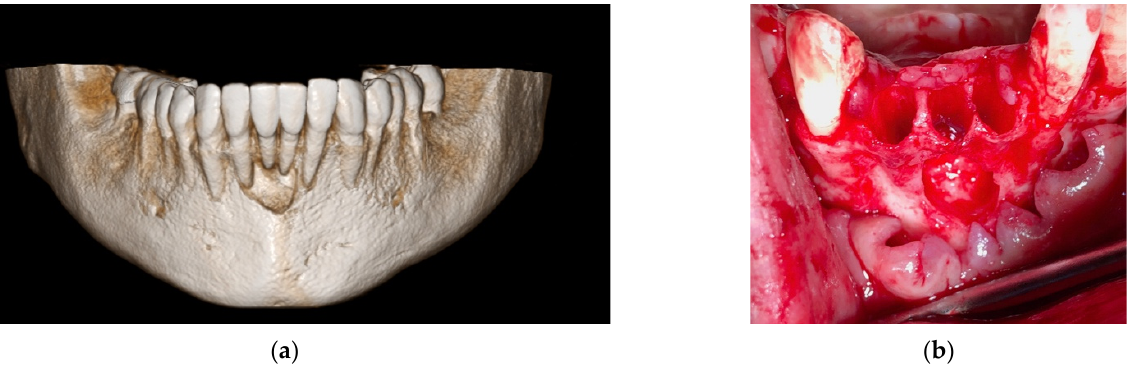
Figure 13. ( a ) Cystic lesion between lower incisors; ( b ) full-thickness flap, extraction of the three incisors and removal of the cyst.